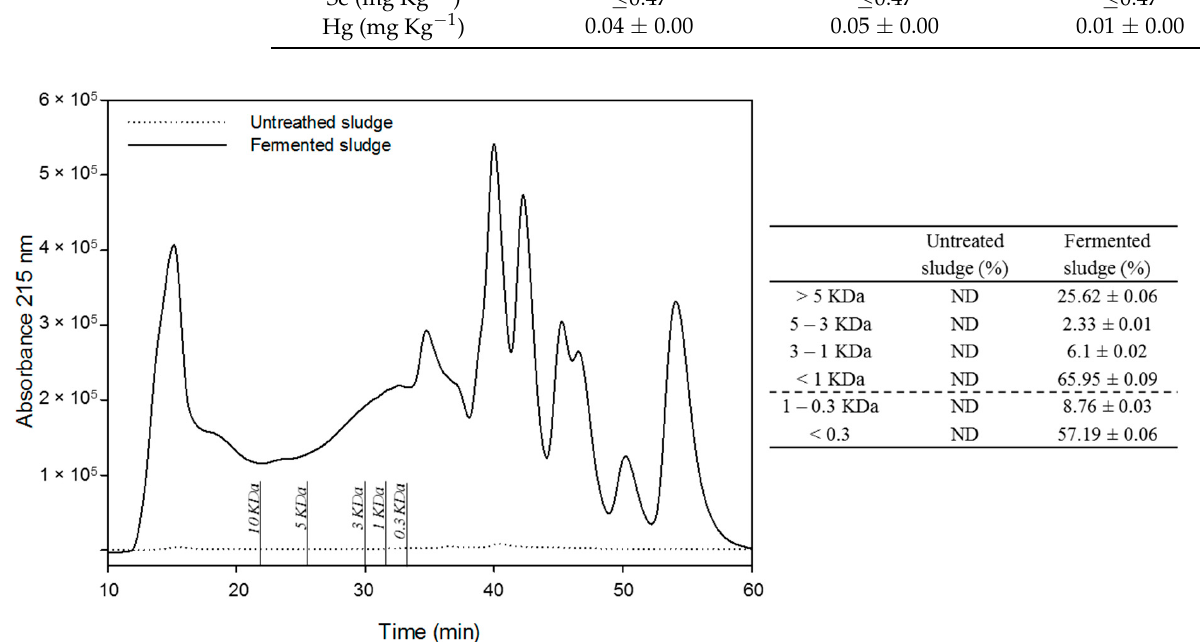
Figure 2. The molecular size distribution profile of the organic fraction of the untreated sludge and after fermentation with B. licheniformis.